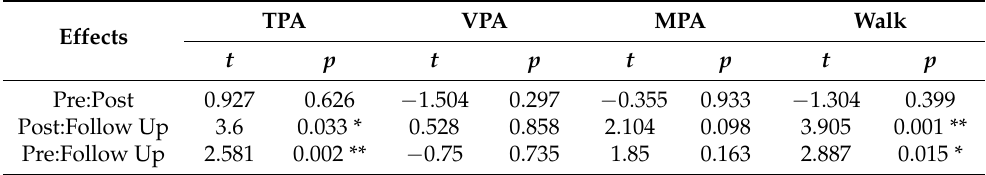
Table 5. Results of post hoc tests for all PA variables for the WeMindful group.